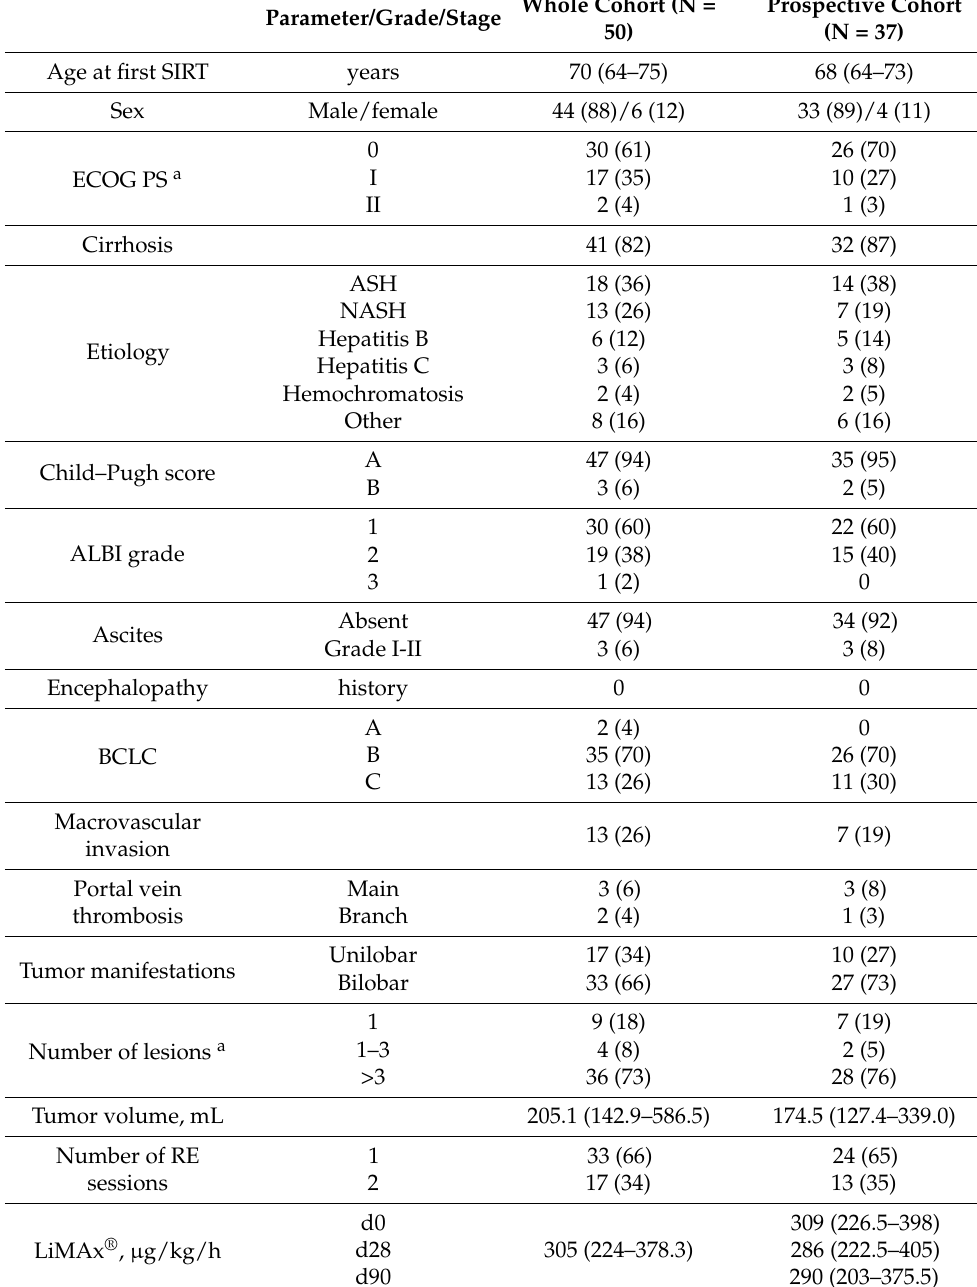
Table 1. Baseline